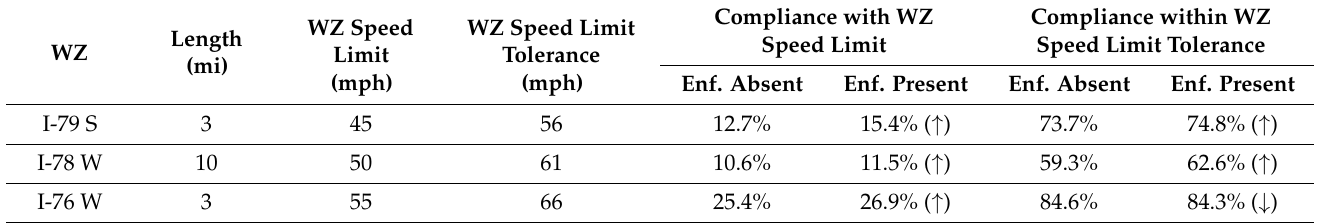
Table 2. Summary of average speed compliance inside the work zone with and without enforcement.